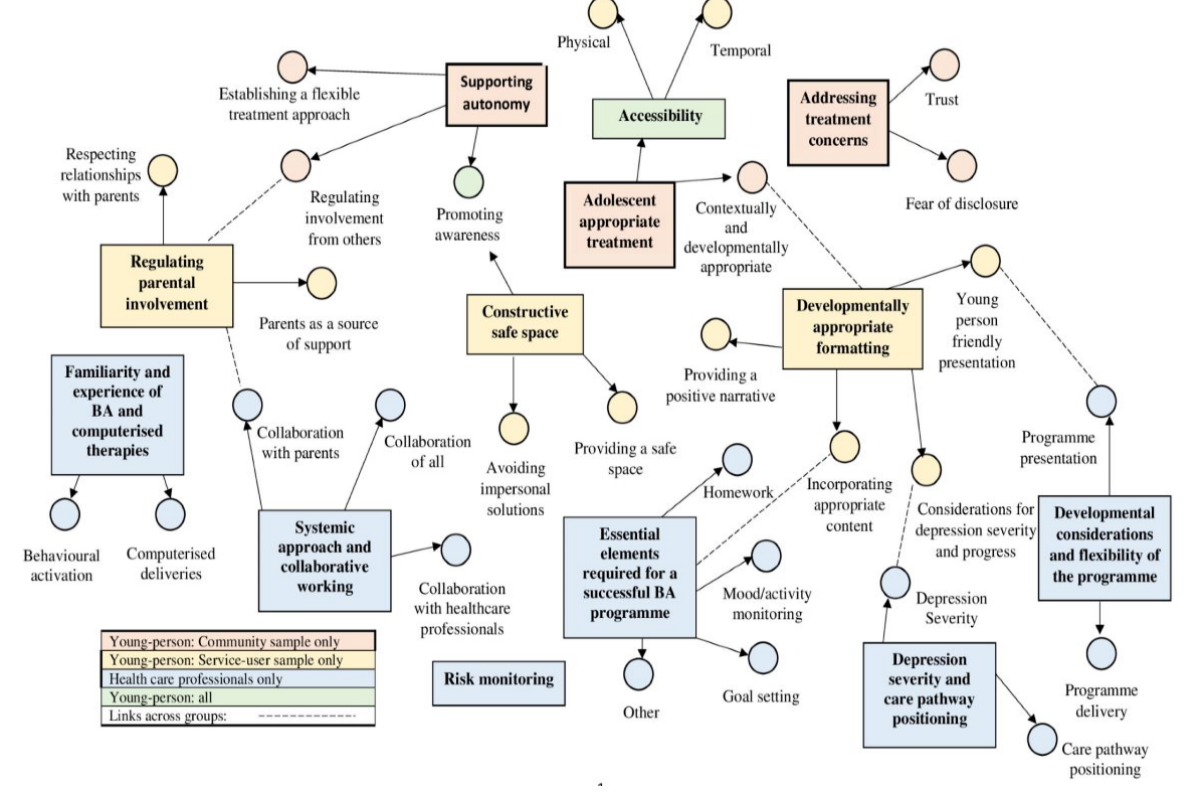
Young People: Community